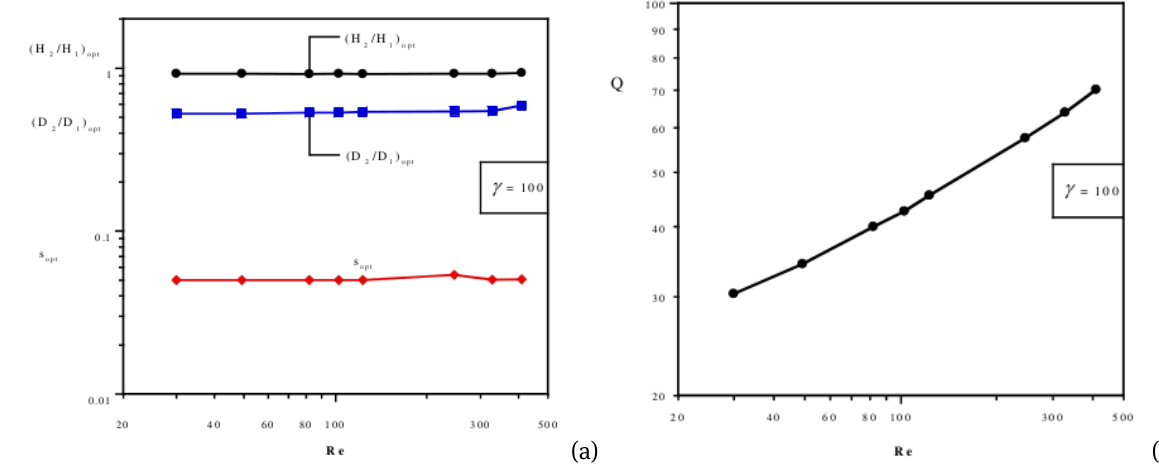
Figure 2: (a) The influence of Reynolds number on the optimized geometric configuration, for thermal conductivity ratio of 100 for double row finned heat sink. (b) The maximized rate of heat transfer as a function of Reynolds number with the conductivity ratio γ equal to 100 for double row finned heat sink.